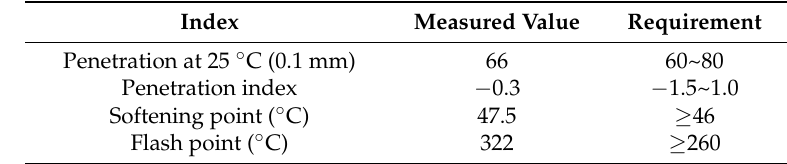
Table 3. Basic properties of 70# matrix